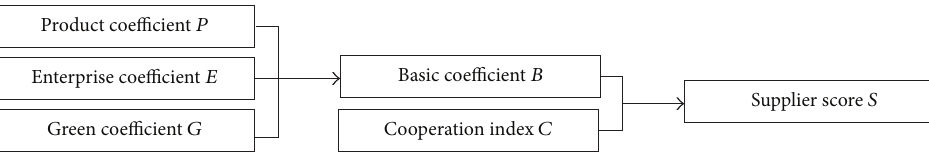
Figure 3: Evaluation frame of green building parts supplier.